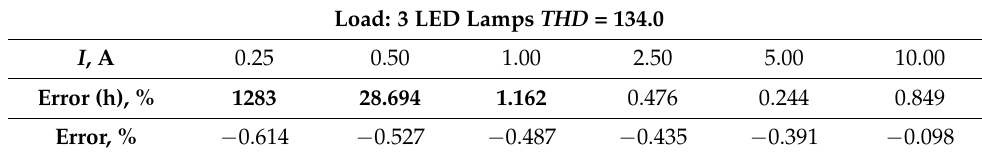
Table 8. Dependence of the electronic energy meter errors on the current value for THD = 134. Load: 3 LED Lamps THD = 134.0